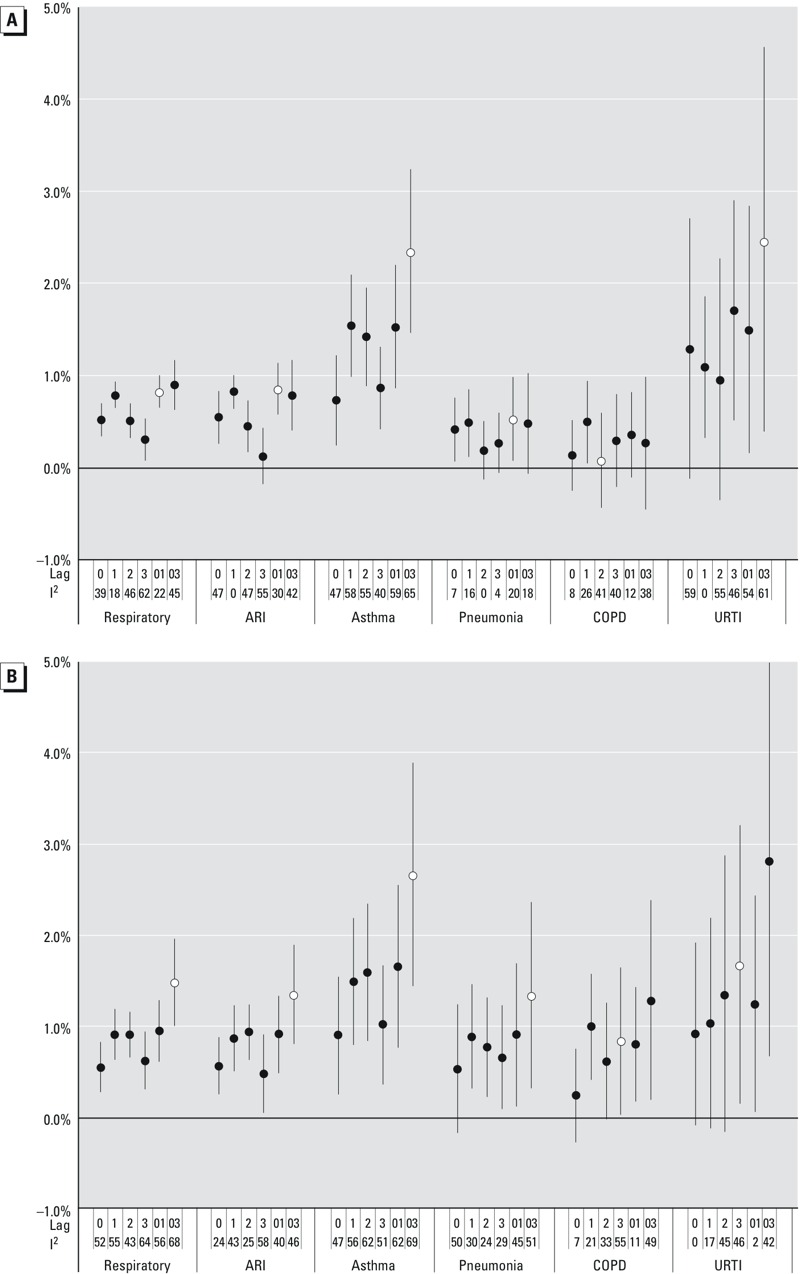
Excess risks (95% CI) per 10-ppb ozone for respiratory outcomes by lag, with I2statistic, for (A) full year, and (B) warm season.
l = lag of best fit, as identified as the lowest sum of AICs over all CZ analyses. Lag0 = same-day exposure, lag1 = exposure 1 day prior, etc. Lag01 = mean of lag0 and lag1, lag03 = mean of lags 0 through 3, etc. Models adjusted for apparent temperature (lag0 and lag13) and influenza visits. I2 = [(Q – df)/Q] × 100. Full year = all months available; warm = limited to May through October. Reported risks [(OR – 1) × 100] are pooled estimates using random effects meta-analysis from CZ-specific estimates obtained using conditional logistic regression comparing exposures on visit days with others of the same day of the week within the same month, adjusting for apparent temperature (lag0 and lag13) and county influenza visits.